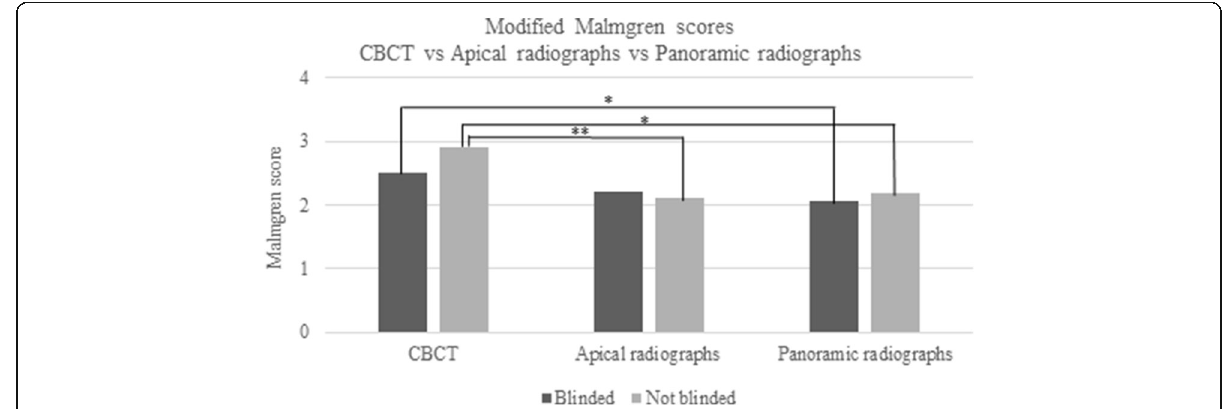
Fig. 7 Modified Malmgren scores of CBCT versus periapical radiographs (PA) versus panoramic radiographs (PAN). PAN differed significantly ( p < 0.05) in the assessment of both blinded and not blinded modified Malmgren score compared to CBCT. Similarly, PA differed significantly in not blinded ( p < 0.01) compared to